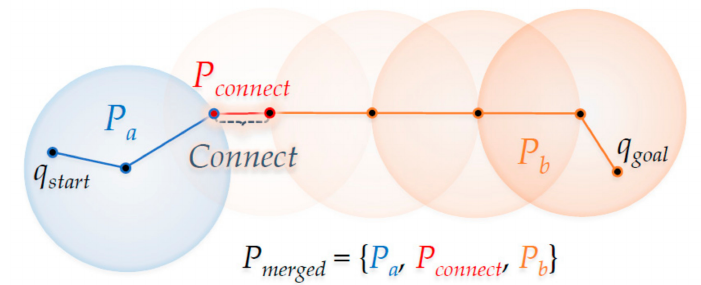
Figure 4. The ‘Connect’ method from the RRT-Connect